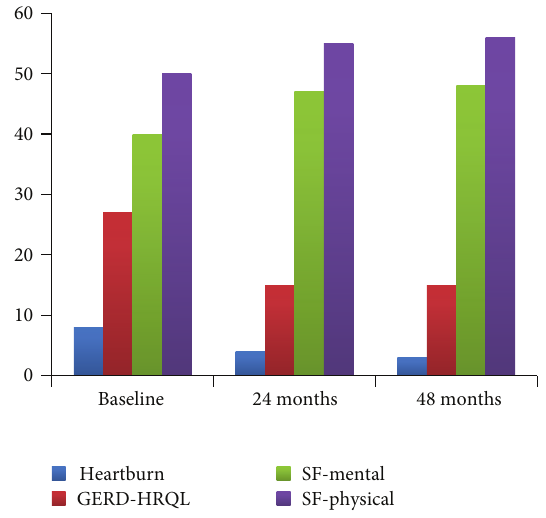
Figure 6: Symptoms and quality of life after